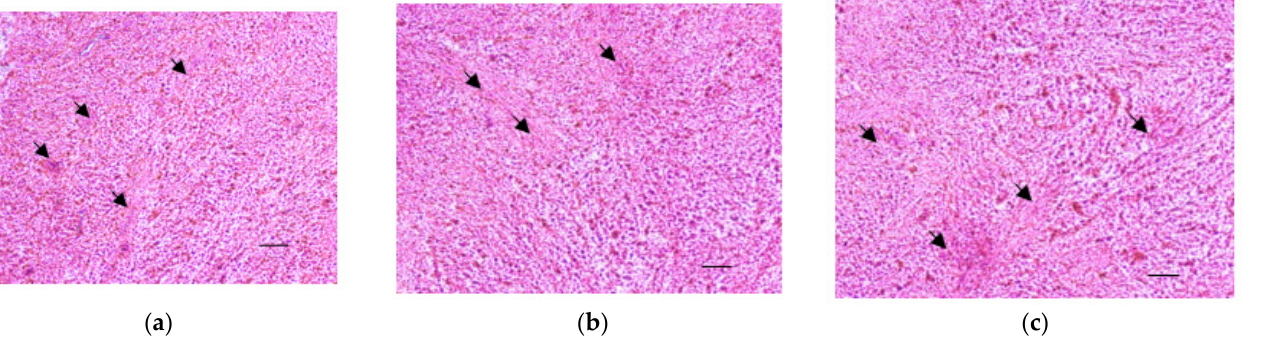
Figure 4. Measurement of HMGA2 gene expression (fold change relative to reference β -actin gene) in two independent primary UL cell lines at different passages.